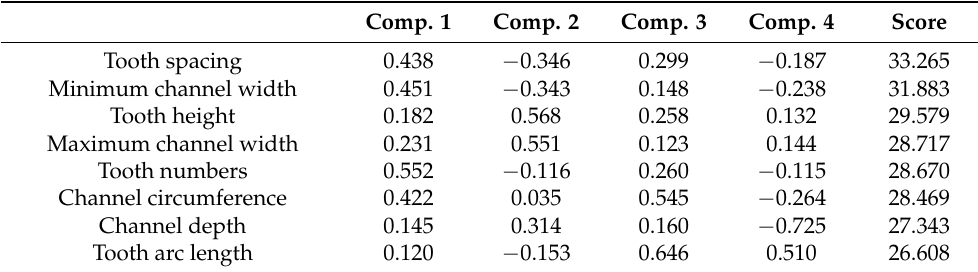
Table 2. The principal component matrix of four principal elements and the score of each structural